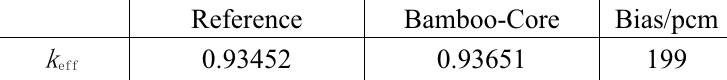
Table (cid:267) . Effective multiplication factor of S3 state